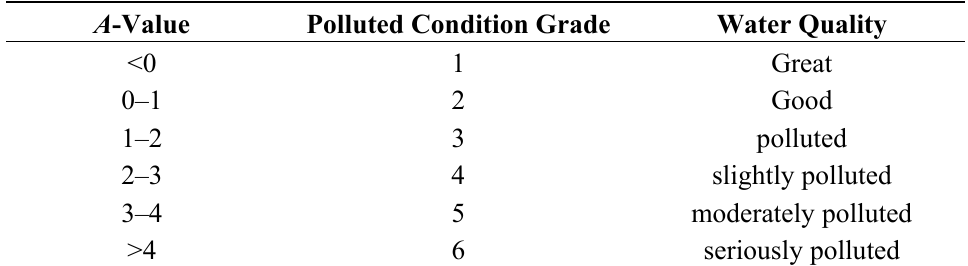
Table 2. Grade of comprehensive quality